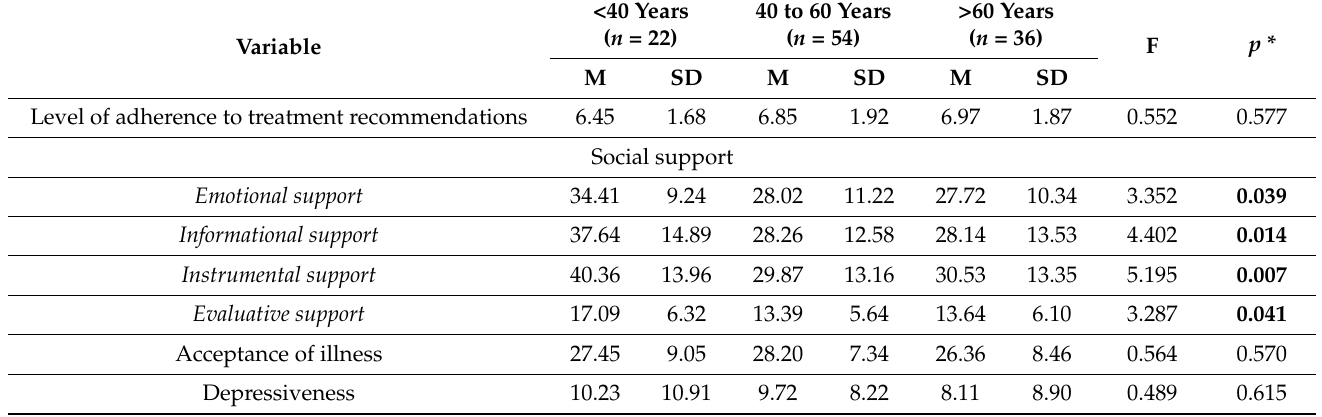
Table 3. Adherence to treatment recommendations, social support according to the ISSB, acceptance of disease according to the AIS, and depression according to the BDI among liver transplant patients by